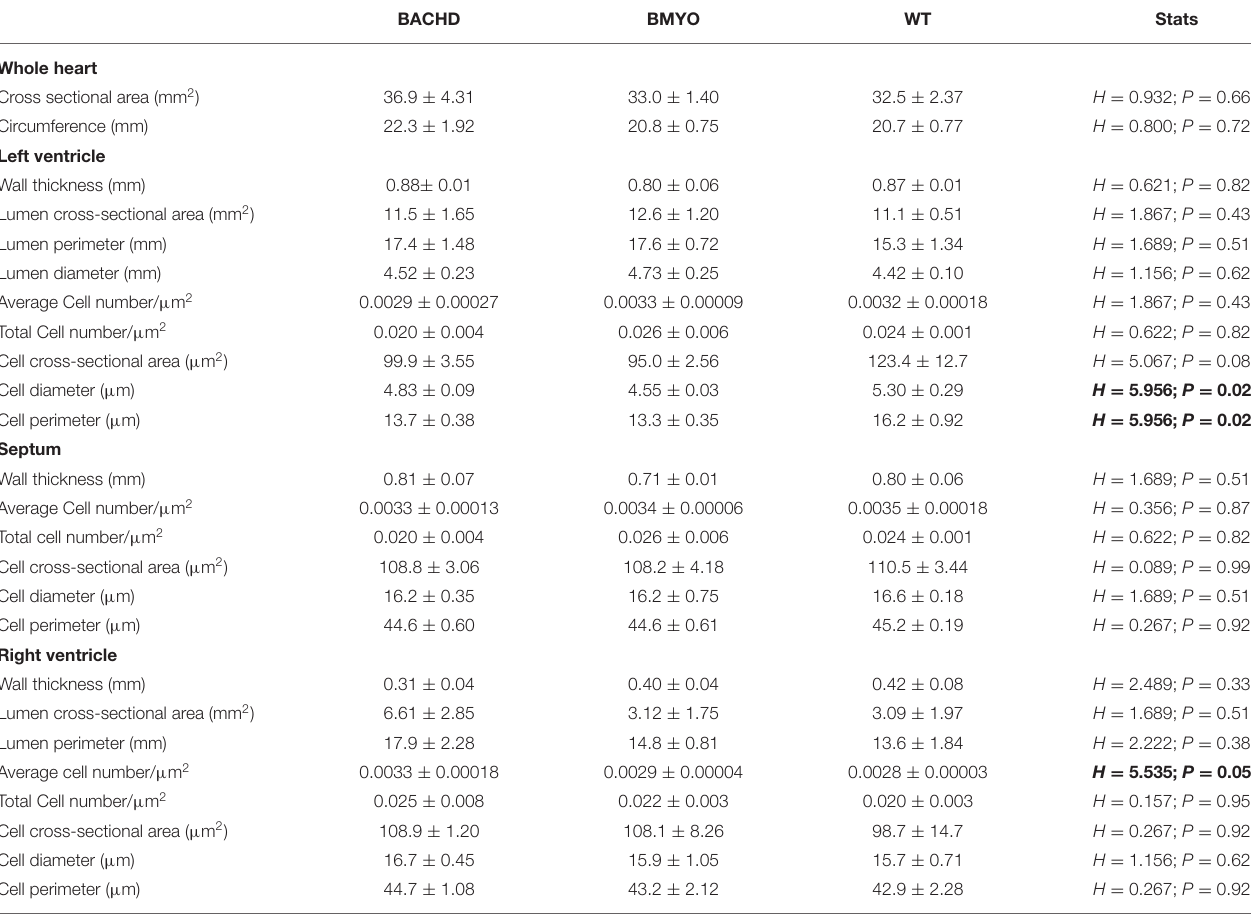
Sections (2/animal) at the mid-ventricular level were chosen based on the visual presence of papillary muscles in the left ventricle (Lv). Since the left and right ventricles (Rv) were not perfectly round, we refer to the length of the lumen as perimeter. Cells were counted in 2-3 ROI of equal size (153.21 µ m × 153.21 µ m)/image and summed. The sums from 10-15 images (Lv) or 5-10 images (Rv and Septum)/animal were averaged and then divided by the ROI total area. Values are presented as the Mean ± SEM, statistical differences were determined using the Kruskal-Wallis one way ANOVA on ranks followed by Dunn’s multiple comparisons test. Bold values indicate statistically significant genotypic differences. n = 3 animals per genotype, all